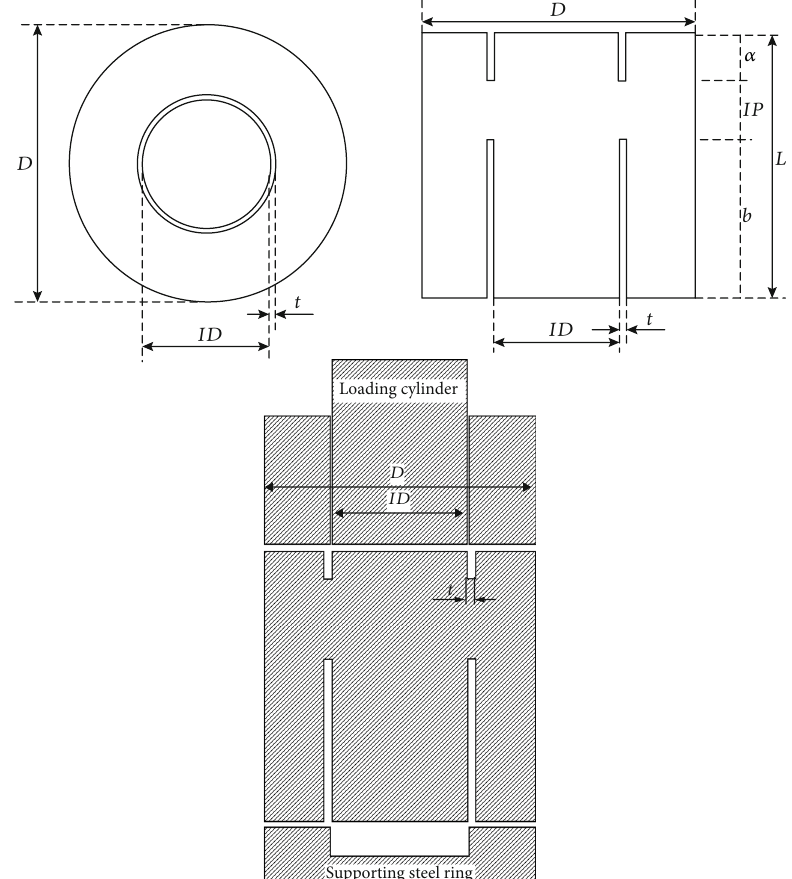
Figure 4: Layout of PTS specimen [43].